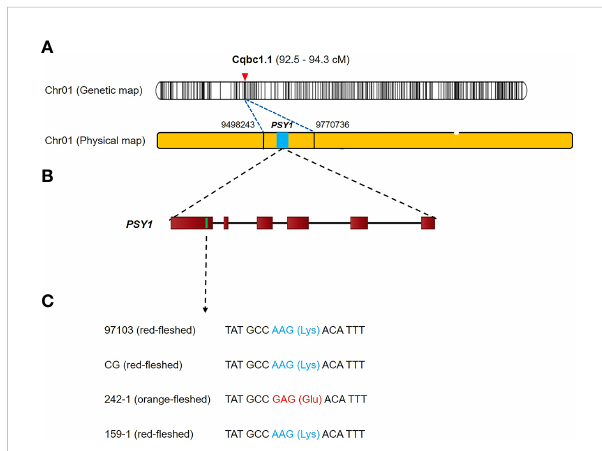
FIGURE 6 Genetic mapping and phenotypic analysis of the carotenoid biosynthesis gene PSY1 in watermelon. (A) The preliminary genetic map and physical map. The PSY1 gene is located on chromosome 1. (B) Structure of the PSY1 gene. A nonsynonymous SNP mutant is located in the fi rst exon at 9,539,129 bp on chromosome 1. (C) The SNP (A ! G) results in the conversion of a lysine (Lys) to a glutamic acid